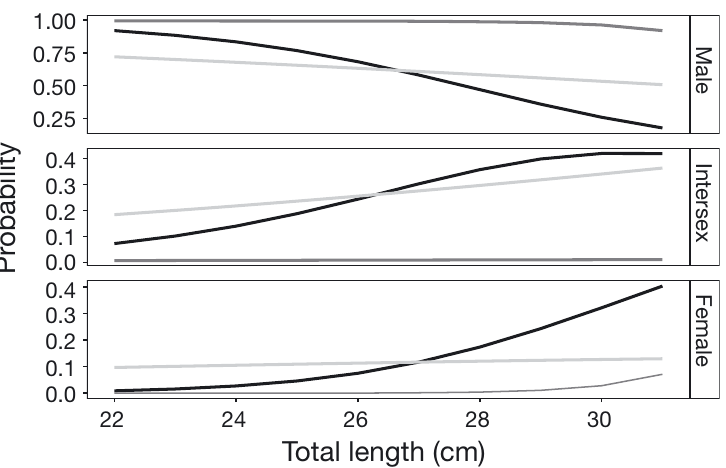
Fig. 6. Estimated multinomial regression model for sex data derived from interaction between ‘Total length’ and ‘Origin’ predictor variables. The pre- dicted probabilities are plotted against total length of the gilthead seabream specimens by the 3 levels of origin for different categories of the sex outcome variable. Farm-associated specimens are represented by black, farmed by dark grey and wild by light grey